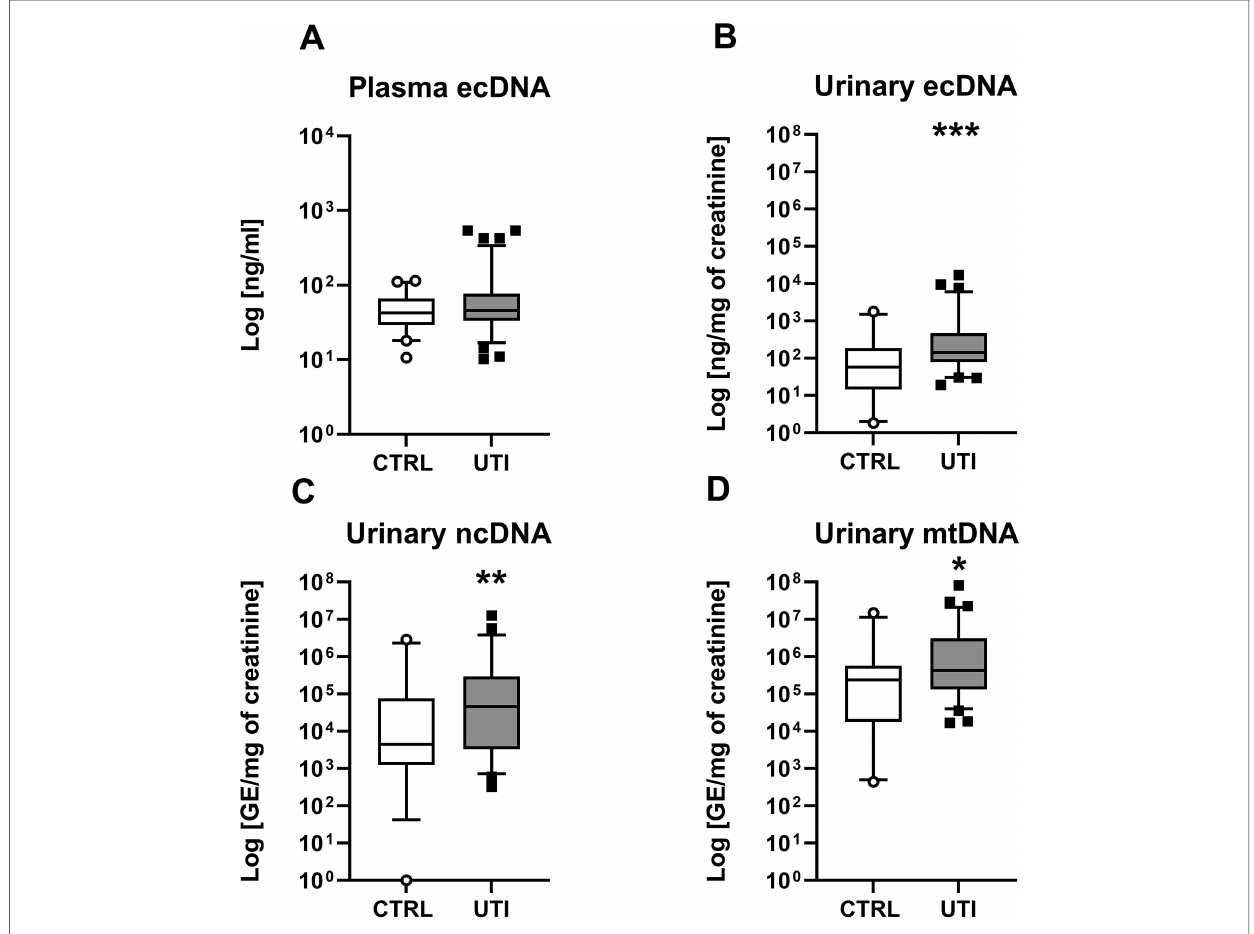
FIGURE 1 Concentration of extracellular DNA (ecDNA) in children with urinary tract infection (UTI) and in healthy controls (CTRL). ( A ) Plasma total ecDNA, ( B ) Urinary total ecDNA, ( C ) Urinary nuclear DNA (ncDNA), ( D ) Urinary mitochondrial DNA (mtDNA). Results are presented using box plots with median and interquartile range. Data were compared using Mann – Whitney U Test. *Denotes p <0.05, **denotes p <0.01, ***denotes p <0.001 in comparison to healthy